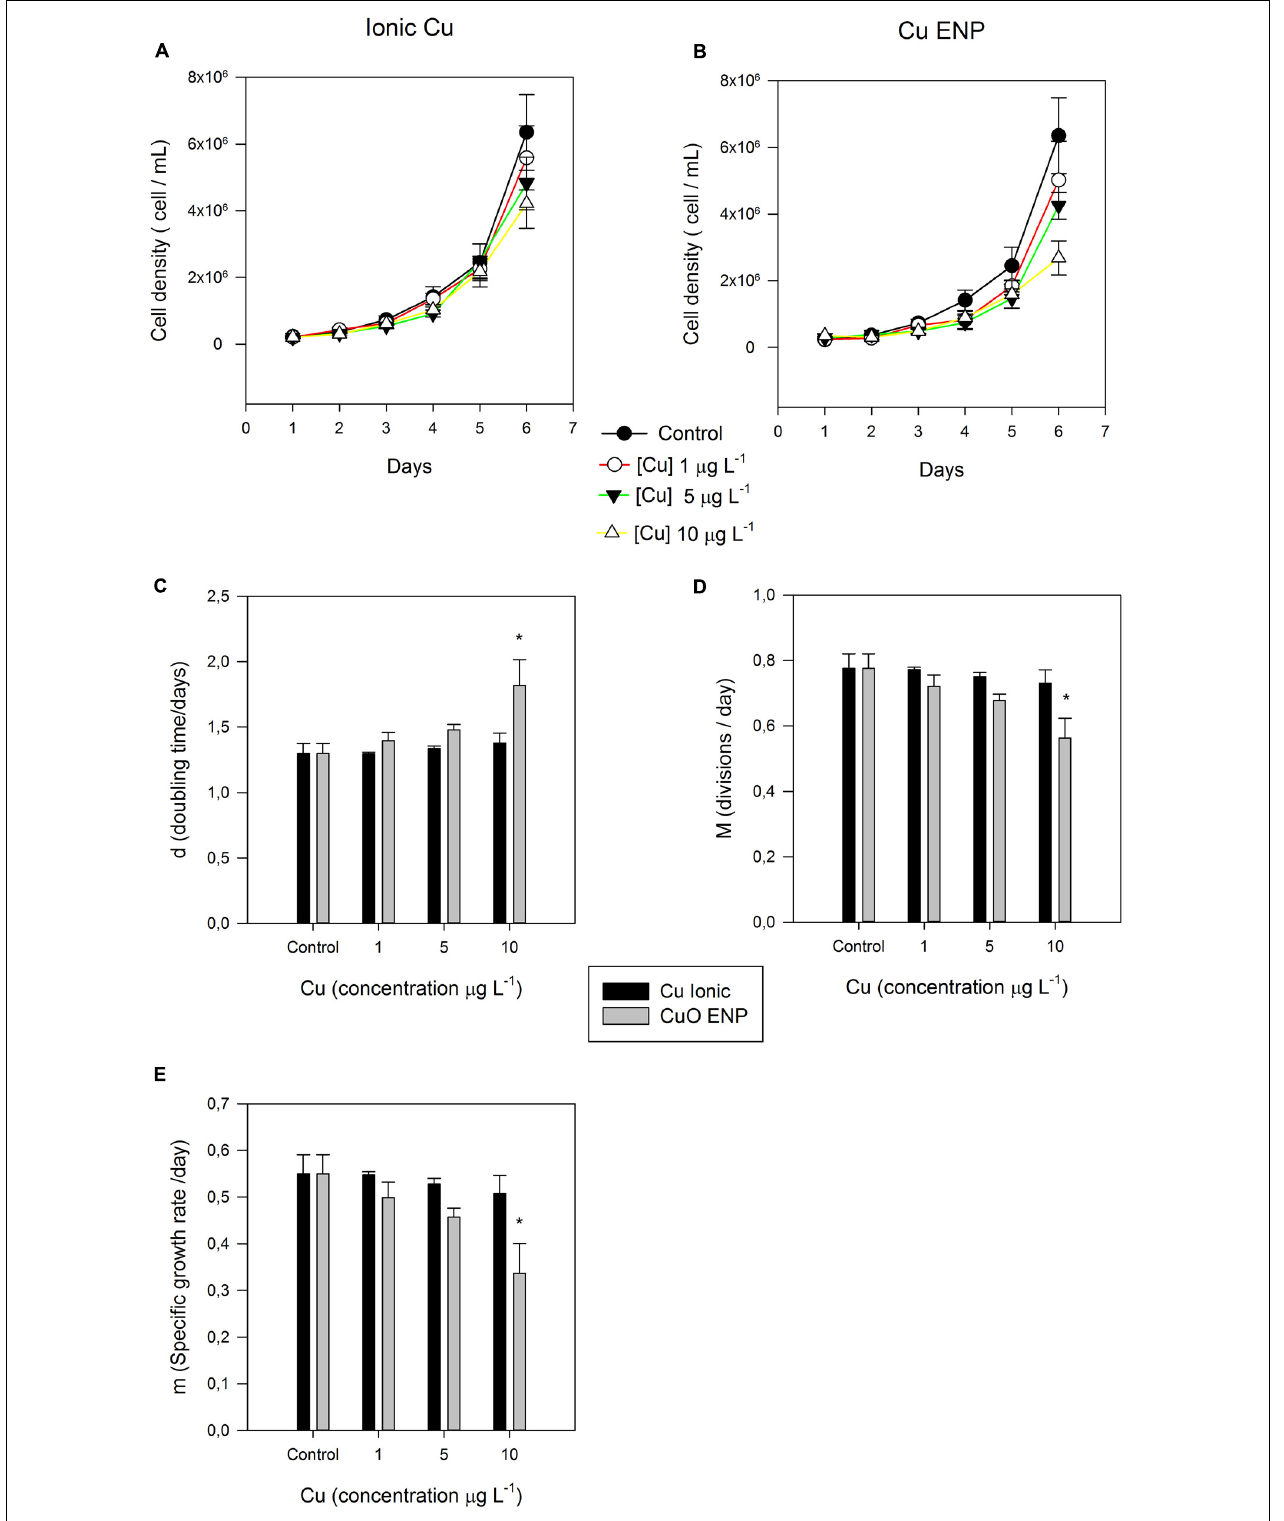
FIGURE 1 | (A,B) Cell density (cell mL - 1 ) of P. tricornutum , during the 6-day experiment. Also shown, (C) doubling time (d), (D) divisions per day (M), and (E) specific growth rate (m), of P. tricornutum after 3 days of exposure to increasing ionic Cu (black bars) and CuO ENP (gray bars) concentrations (average ± standard deviation, N = 3, *indicate significant differences toward the control at p <